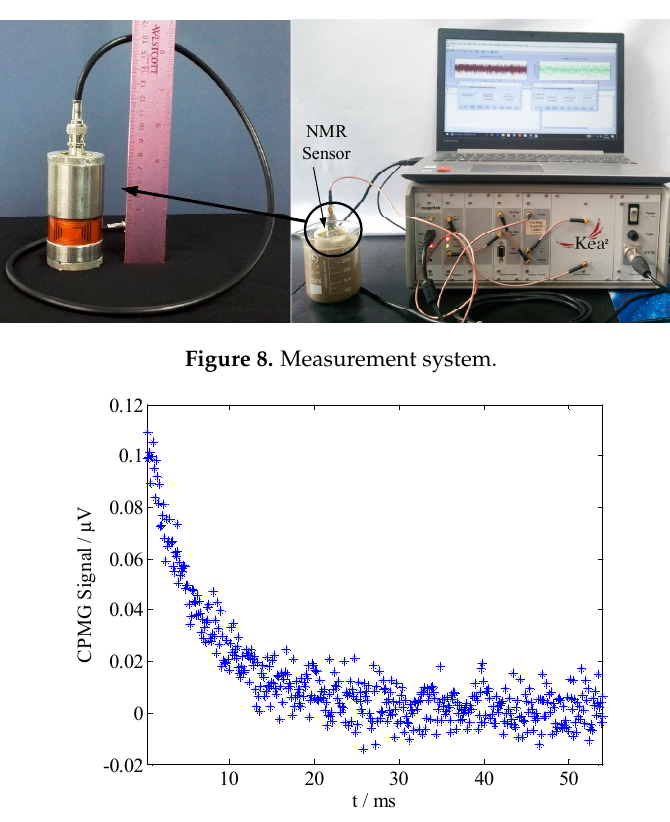
B Figure 7. Sandy soil and silica sand.